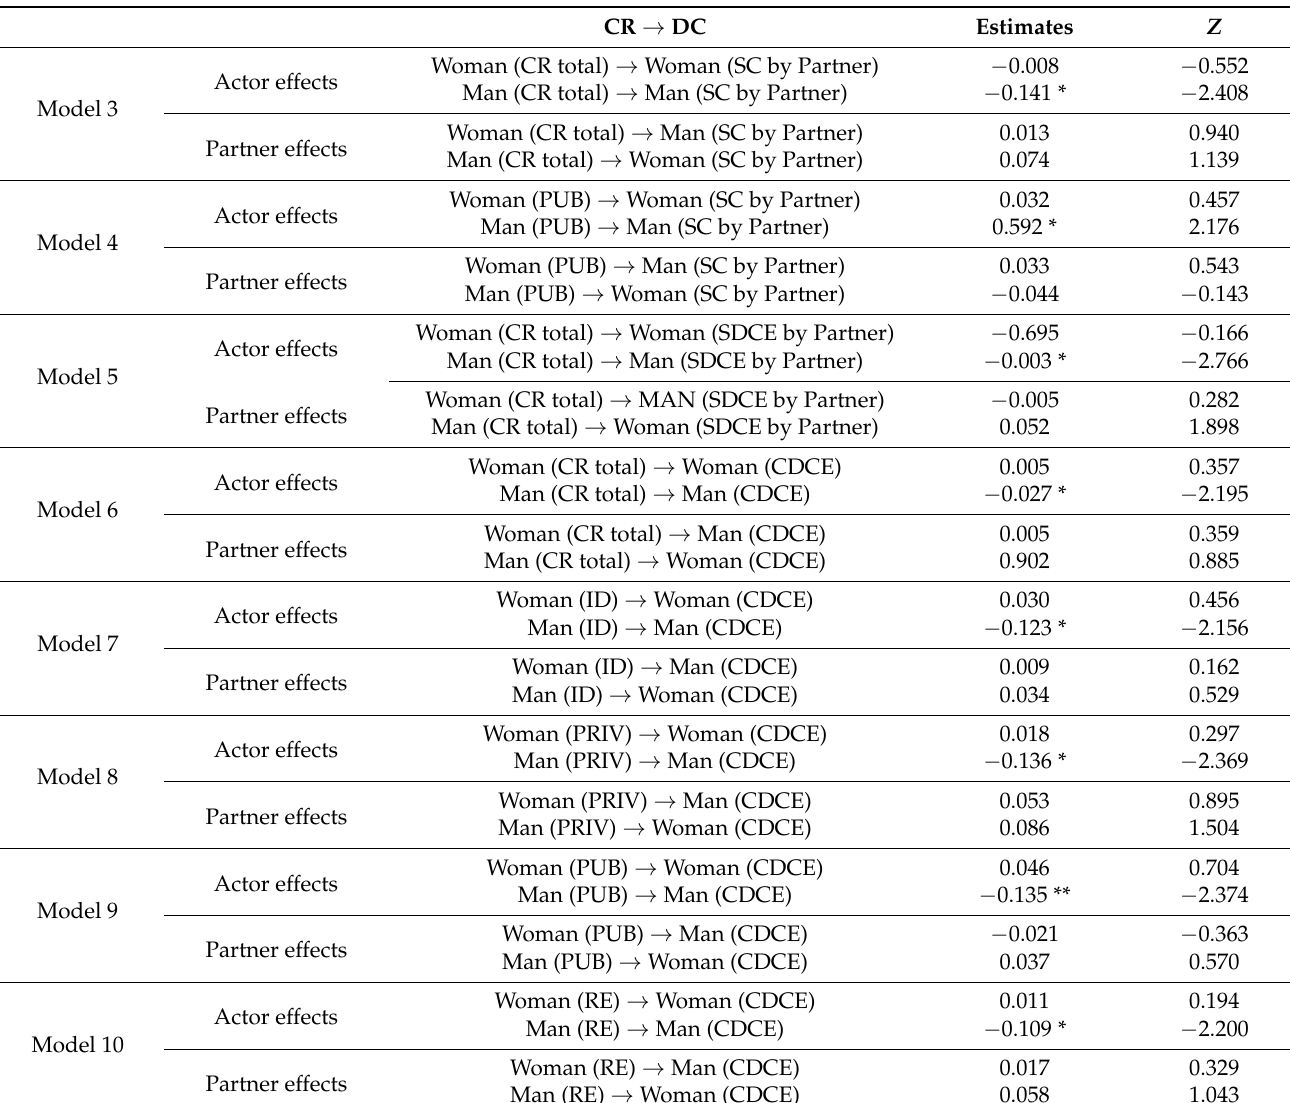
Table 5. Significant religiosity effects on dyadic coping in